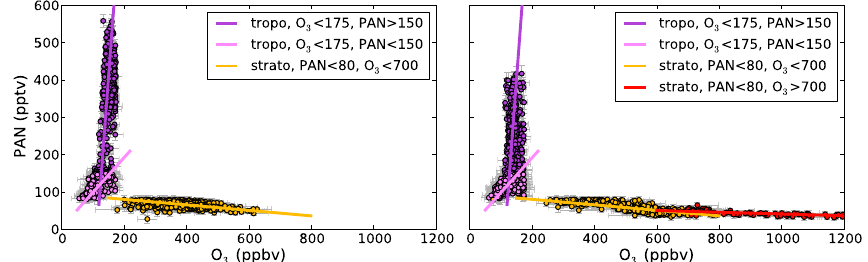
Fig. 9. The subsets of air parcels selected according to the four criteria and the slope derived for each set by the orthogonal distance regression (see Table 2). The western (left) and eastern (right) cross sections are shown separately. The precision of measurements is indicated by error bars in light